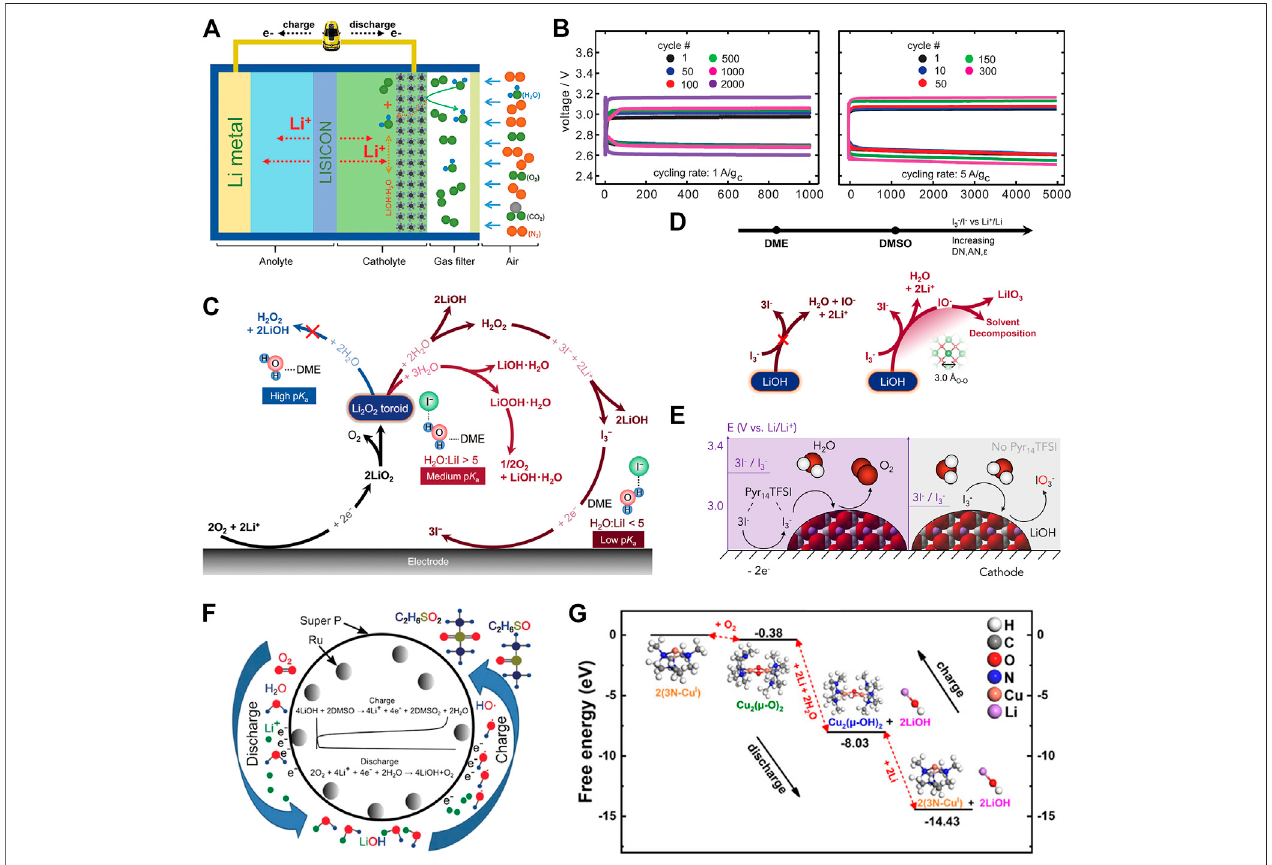
FIGURE 1 | Representative Li − O 2 batteries based on LiOH formation and decomposition. (A) Schematic illustration of Li − air batteries based on LiOH chemistry (Wu et al., 2016). (B) Cycling performance ofLi − air batteries based on LiOH chemistry (Liu et al., 2015). (C) Reaction pathways ofthe formation of LiOH in LiI-containing electrolytes(Tulodziecki et al.,2017). (D) Solvent-dependent oxidation power ofI − 3 /I − redox couple inDMEor DMSO toward theoxidation ofLiOH(Levericket al.,2019). (E) ReversibleoxidationofLiOHbyI − 3 /I − redoxcoupleinPyr 14 TFSI/TEGDMEelectrolyte(Tempranoetal.,2020). (F) IrreversibleoxidationofLiOHbyRucatalyst(Liu et al., 2017). (G) Energy diagram of reversible oxidation of LiOH by 3N-Cu Ⅰ complex by DFT calculations (Wang et al.,